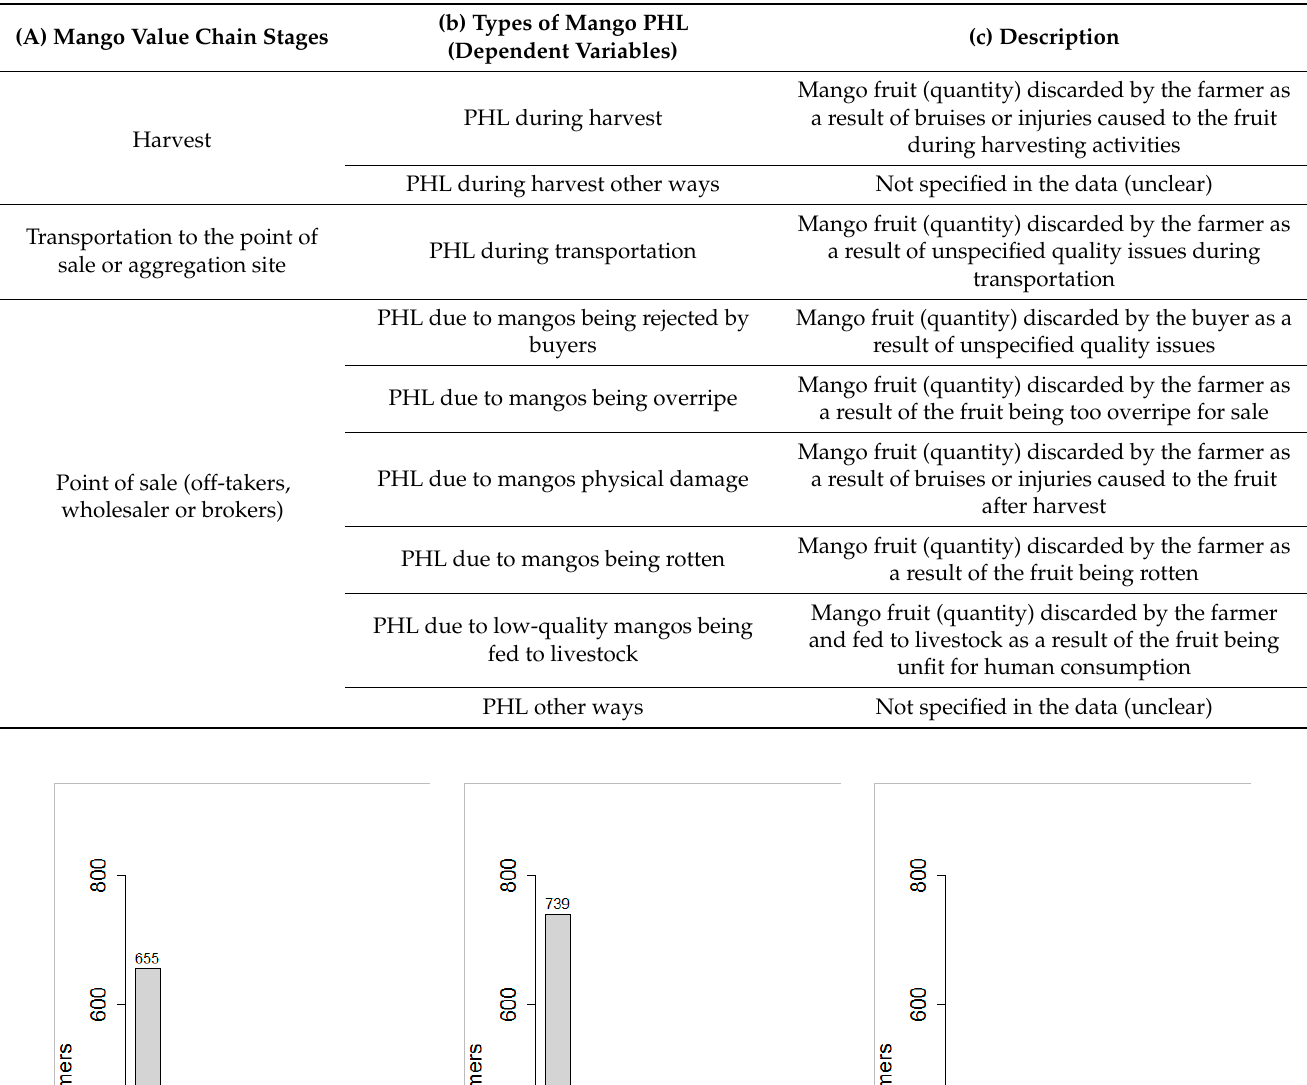
Table 3. Types of mango PHL within the dataset of dependent variables.